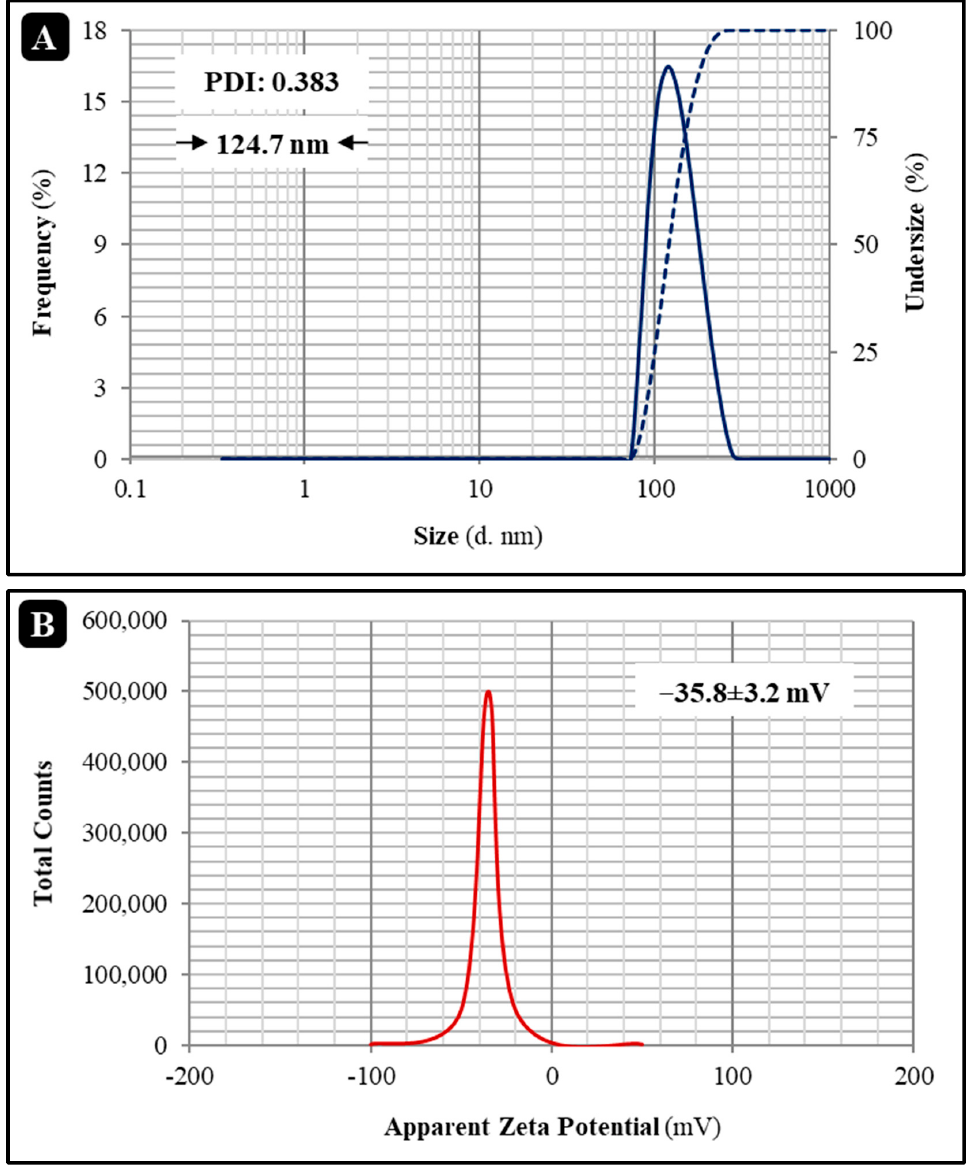
Figure 2. The size distribution ( A ) and zeta potential distribution ( B ) of Allium jesdianum Boiss. EO nanoliposomes.